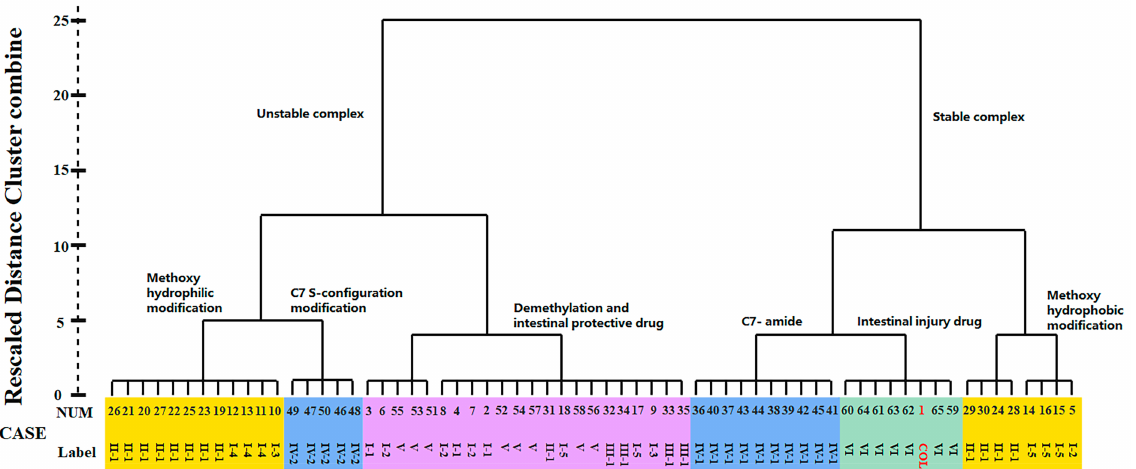
Figure 3. Dendrogram of clustering analysis according to the BE value of miscellaneous